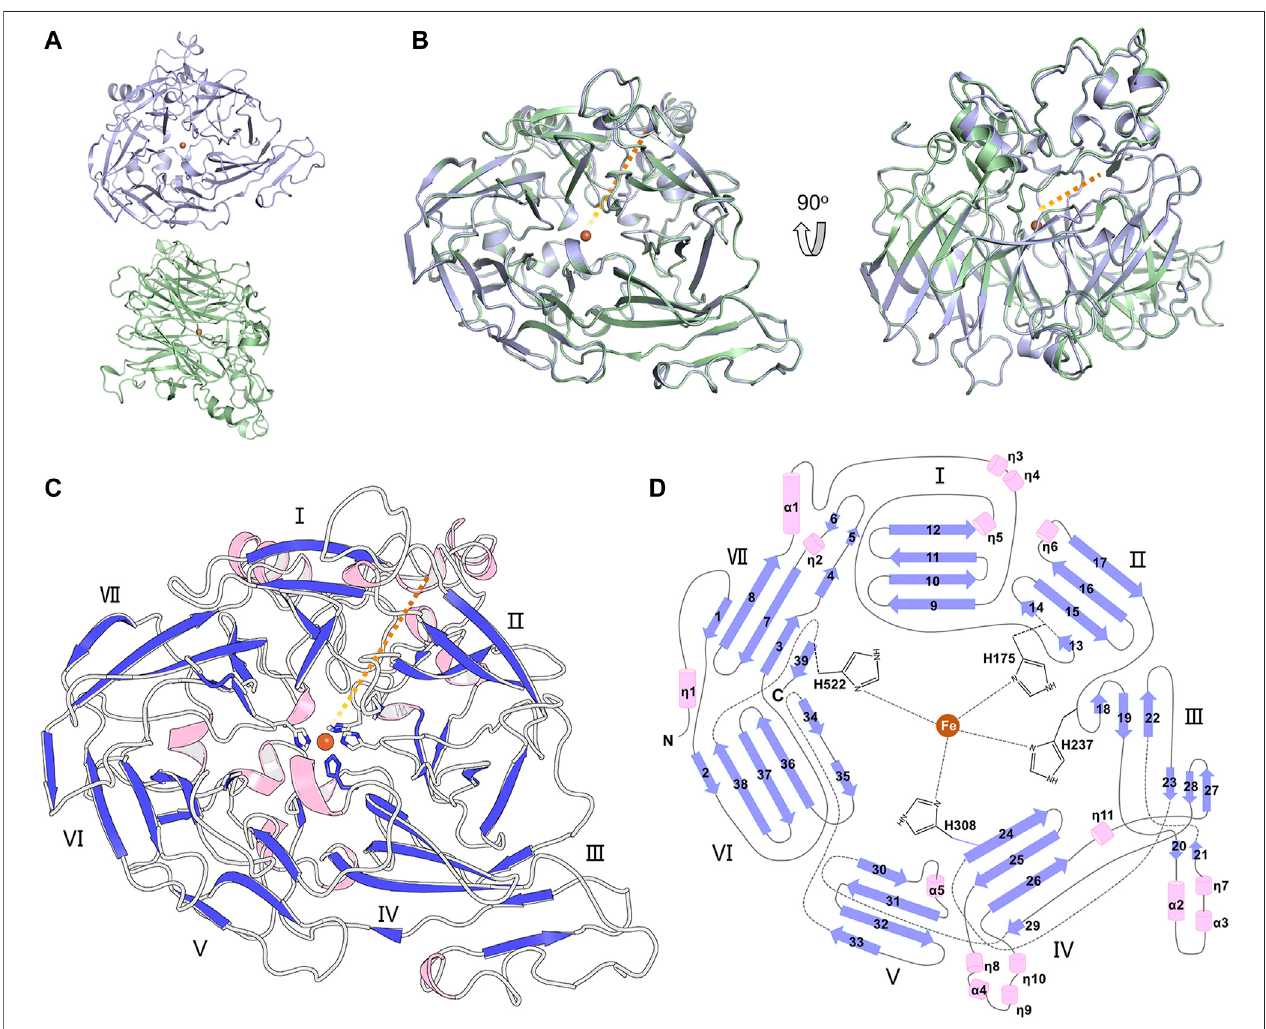
FIGURE2| Overallstructure ofBCMO-1. (A) BCMO-1dimerincrystal.ProteinisinribbonrepresentationwithchainAinlightpurpleandchainBinlightgreen.The ironionisshownassphereandcoloredinbrown. (B) SuperimpositionofchainsAandB.Theorangedashedlineindicatesthetunneltotheactivecenter. (C) Secondary structuralelementsofBCMO-1. α -Helicesand η (3 10 )-helicesareinlightpink; β -strandsareinpurpleblue.Theseven β -propellersarelabeled.Thesidechainsoftheiron- coordinating His are shown in sticks. (D) Topology diagram depicting the secondary structural elements and the iron-coordinating